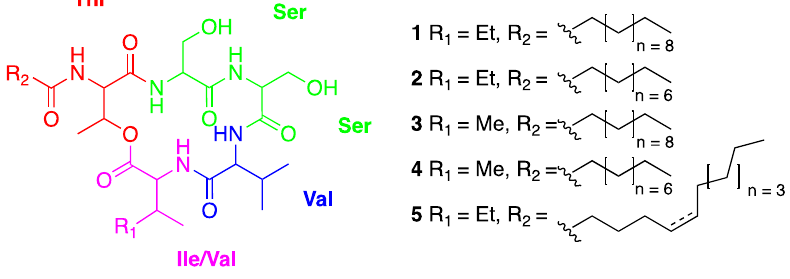
Figure 3. Structures of the isolated compounds 1 to 5 .